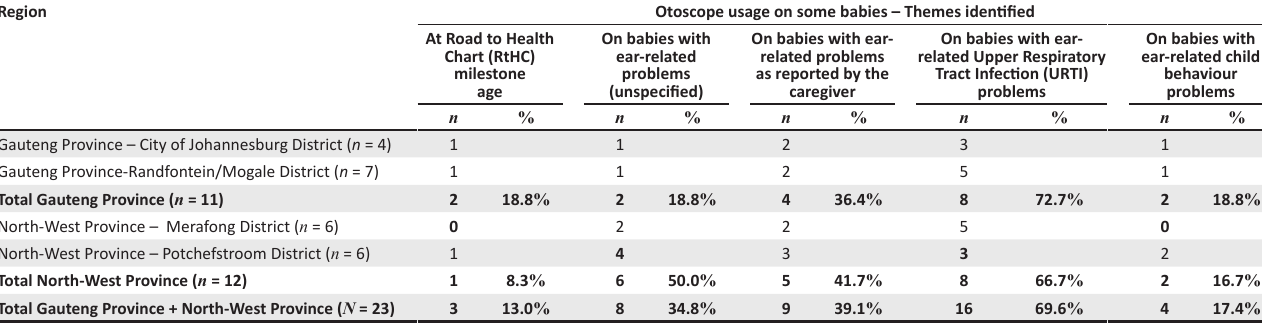
TABLE 1: Themes identified regarding otoscope usage on some babies ( N = 23). Region Otoscope usage on some babies – Themes identified